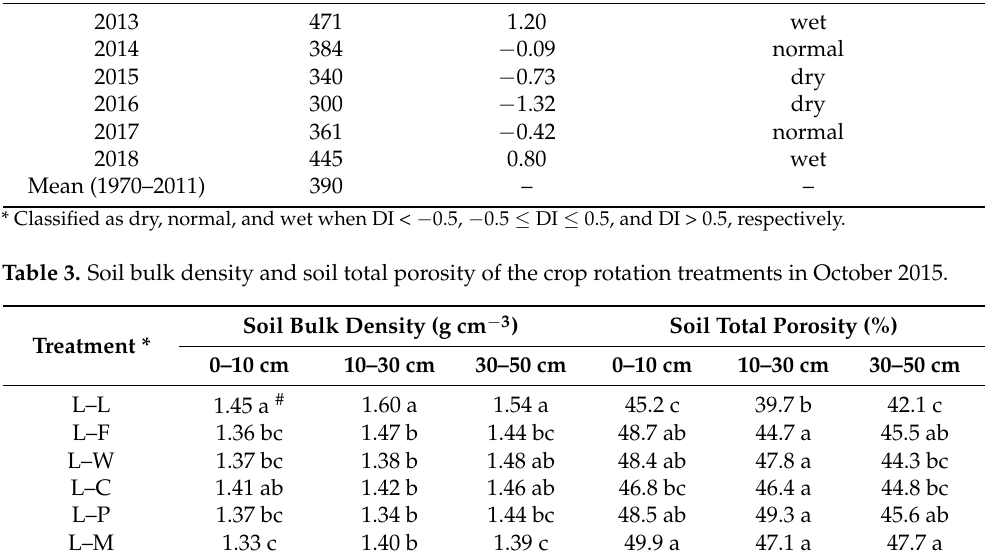
* Treatment abbreviations are defined in Table 1. # Different lowercase letters in the same column represent significant differences at p ≤ 0.05 between treatments.